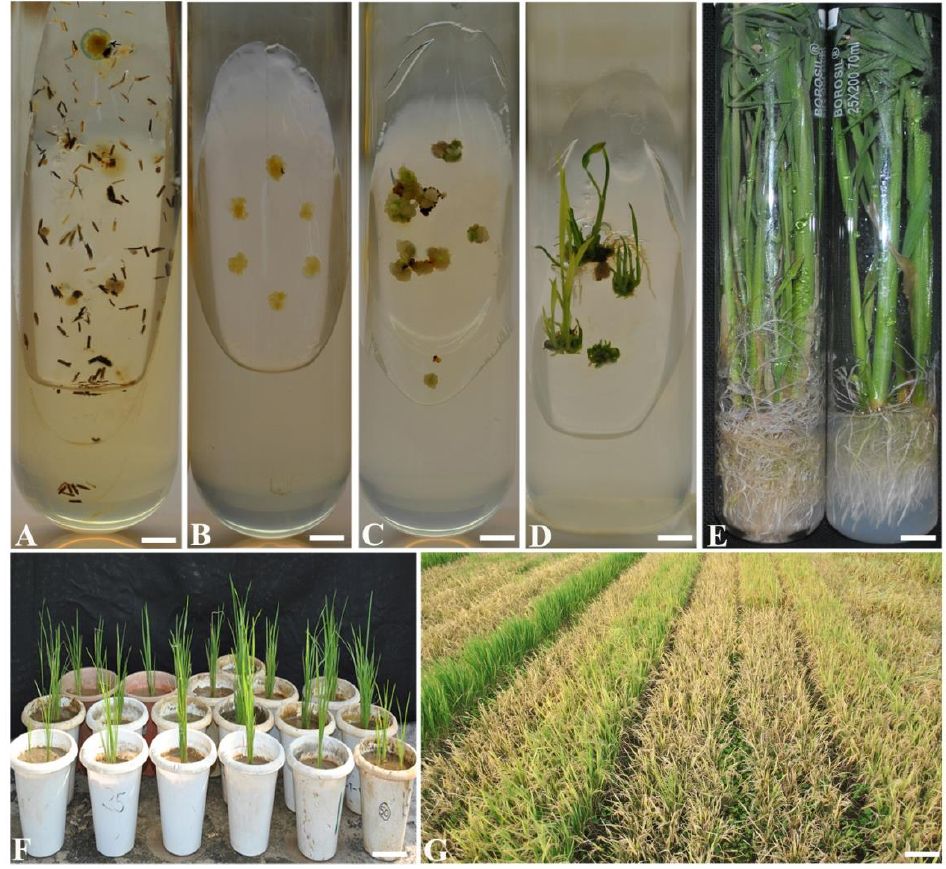
Figure 1. Development of regenerants from non-ratooned and ratooned of 27P63 through androgenesis. ( A ) Calli induction from microspores of anthers (bar 2 mm). ( B ) Calli on regeneration media for green shoot regeneration (bar 2 mm). ( C ) Callus with green spots (bar 2 mm). ( D ) Well grown green shoot regeneration from calli (bar 2 mm). ( E ) Rooting in microshoots (bar 5 mm). ( F ) Acclimatization of anther derived plants (bar 15 cm). ( G ) Variability in DH lines grown in field (bar 20 cm).